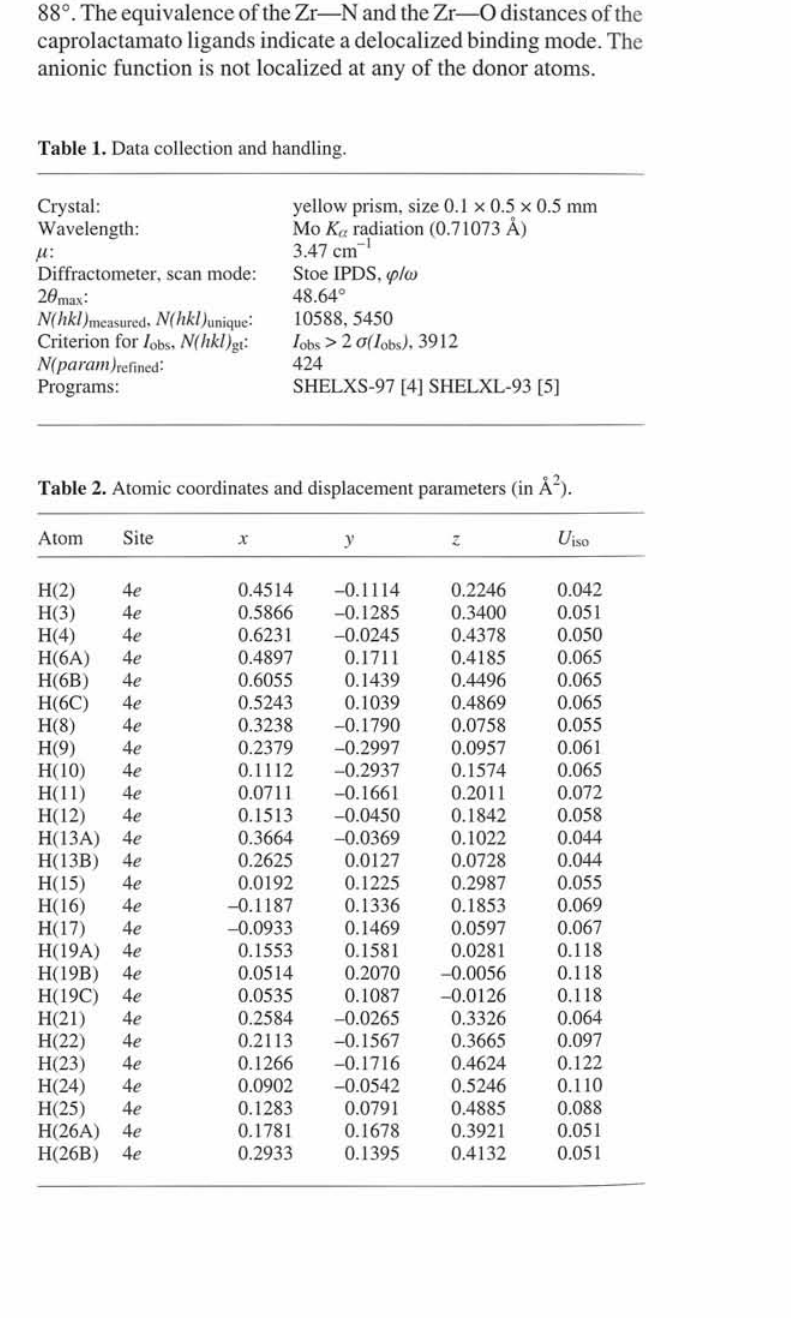
Table 1. Data collection and handling.